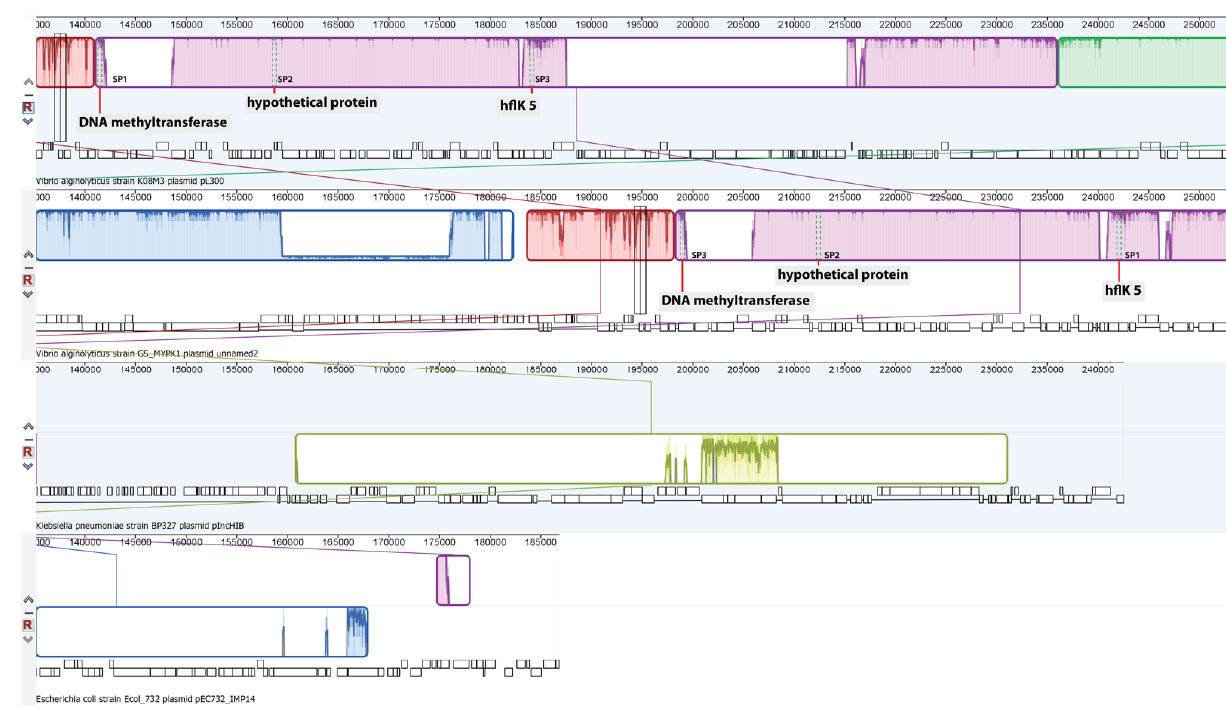
Figure 4. A zoomed-in view of the progressiveMauve alignment between V. alginolyticus pL300 megaplasmid (top) and other plasmids from the blast hit results. The protospacer regions are annotated and shown in the red vertical bar. Homologous genomes are indicated by the connected-with-lines collinear blocks.